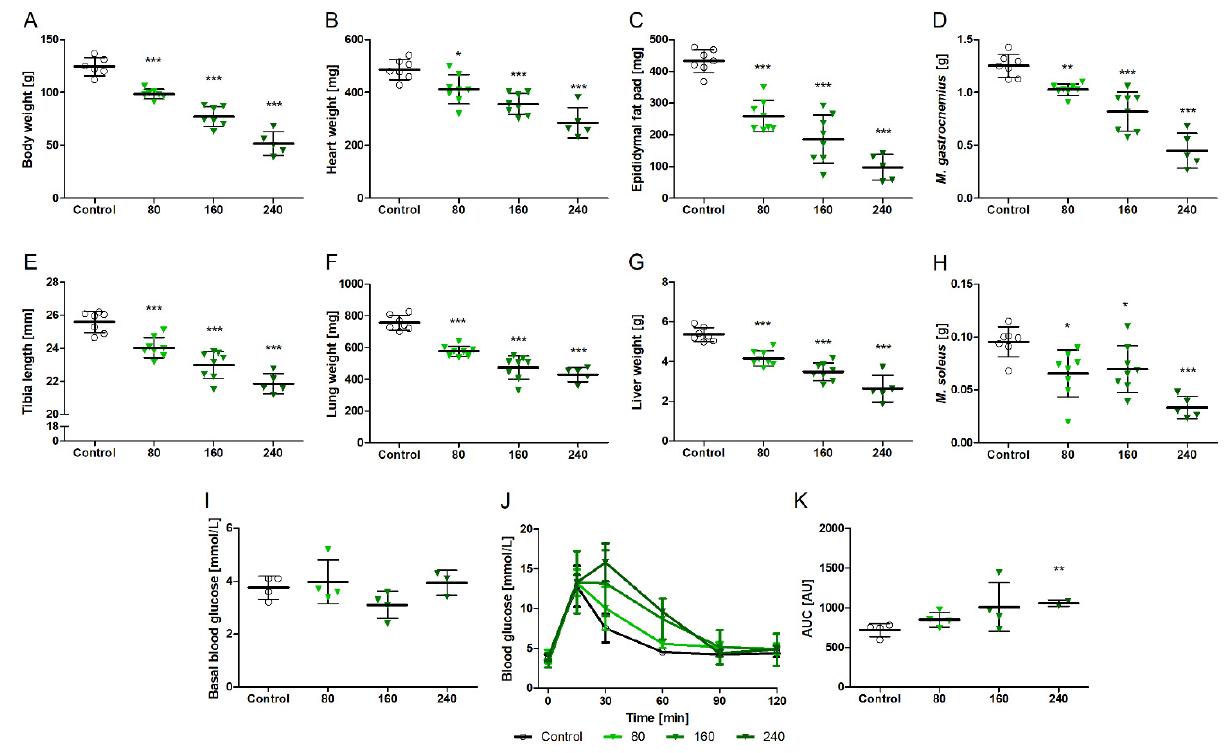
Figure 1. Effects of two weeks of NVP-AEW541 application (80, 160, 240 mg/kg) on the body and organ weights and the glucose tolerance of juvenile rats. Body weight ( A ), organ weights ( B – H ) and tibia length, fasting blood glucose ( I ), time course of glucose removal ( J ), and glucose tolerance ( K ) as determined by area under the curve (AUC). Data are presented as mean ± SD, n = 5–8 per group. Significant differences * p < 0.05; ** p < 0.01; *** p < 0.001 vs.